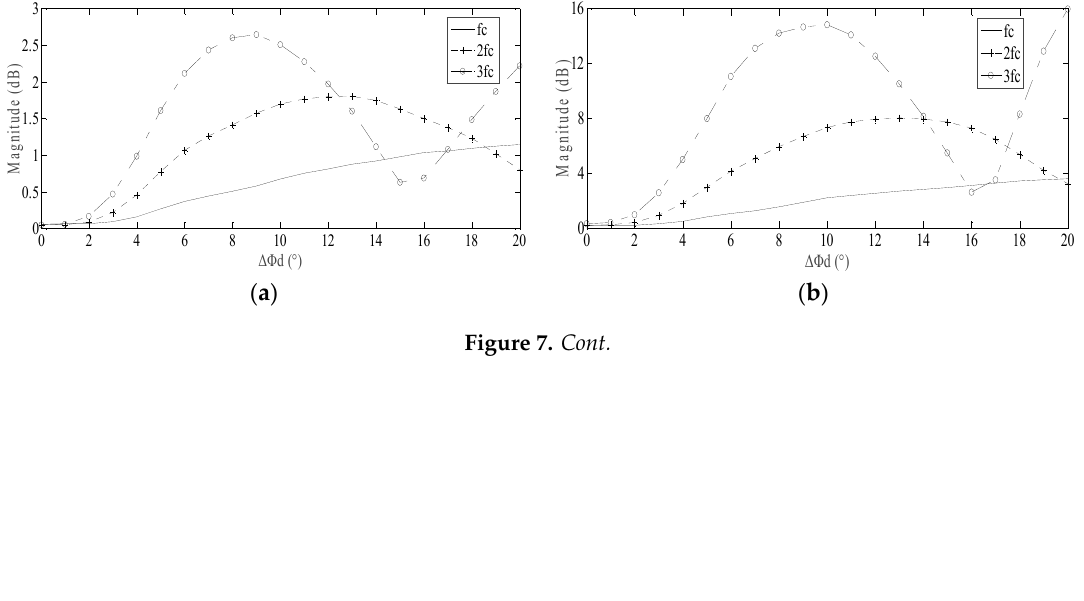
Figure 6. The friction torque for different spall length: ( a ) Δ Φ d =5°; ( b ) Δ Φ d =10°; ( c ) Δ Φ d =15°.